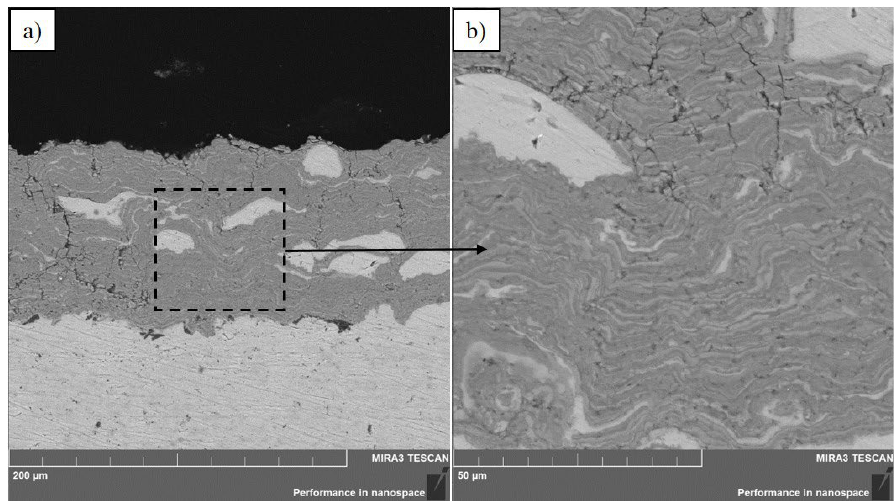
Figure 5. Cross-sectional microstructure of Ti3 coating. Microstructure of ×1000 ( a ) and ×3000 ( b ).